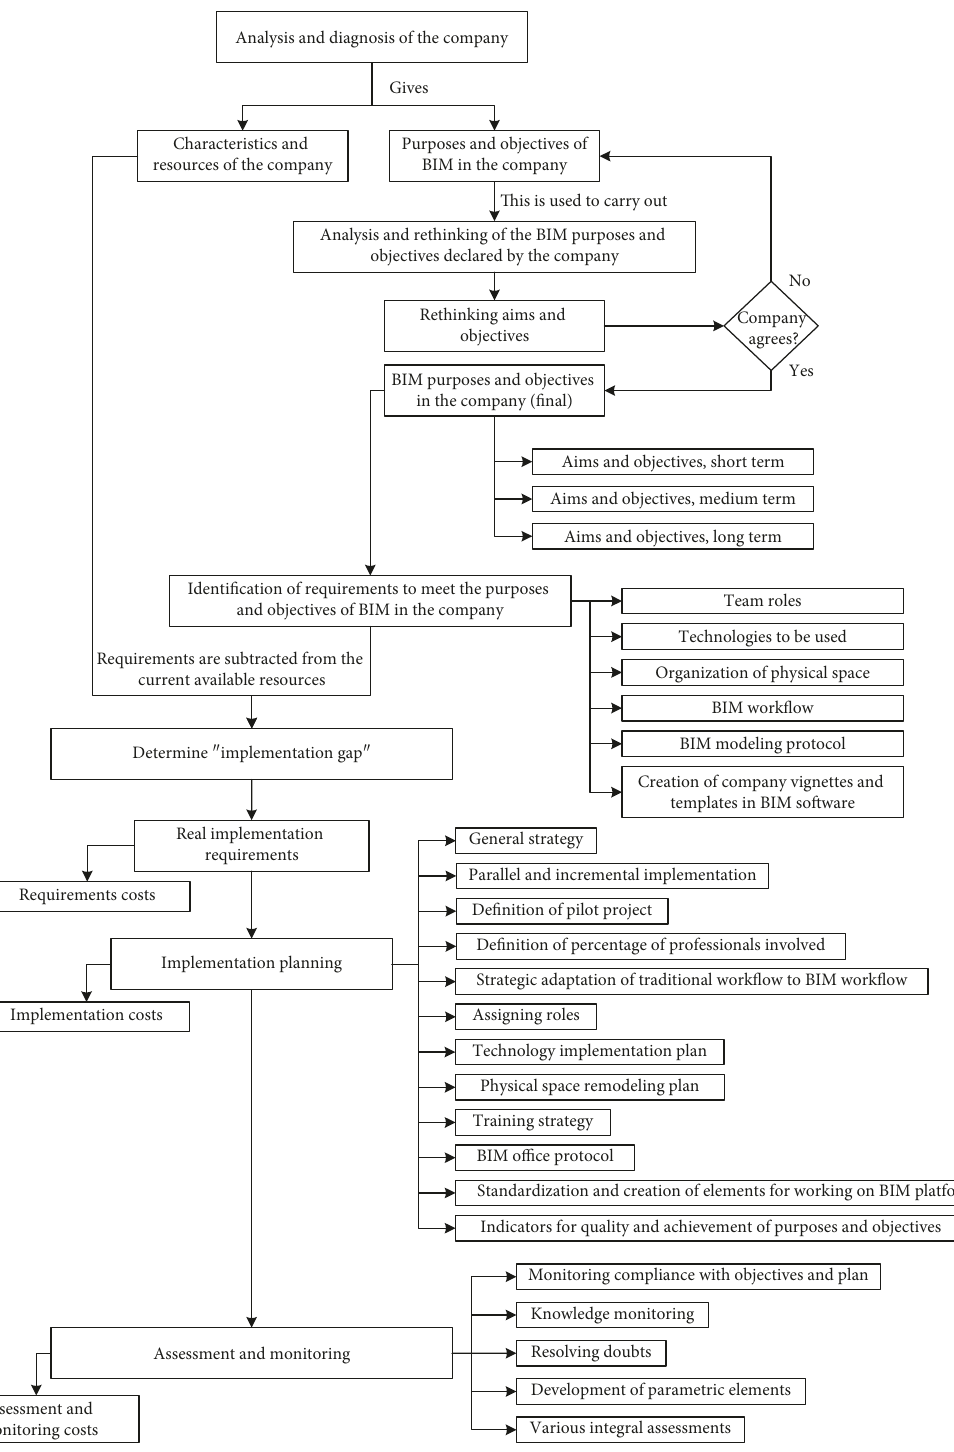
Figure 2: Methodological model for BIM implementation in structural engineering companies